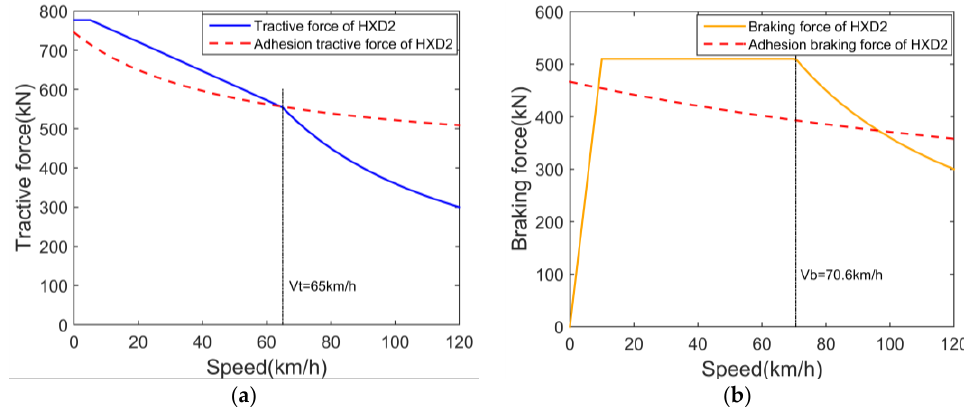
Figure 2. Traction/Braking force and adhesion force of a locomotive (HXD2): ( a ) traction force and adhesion force; ( b ) braking force and adhesion force.